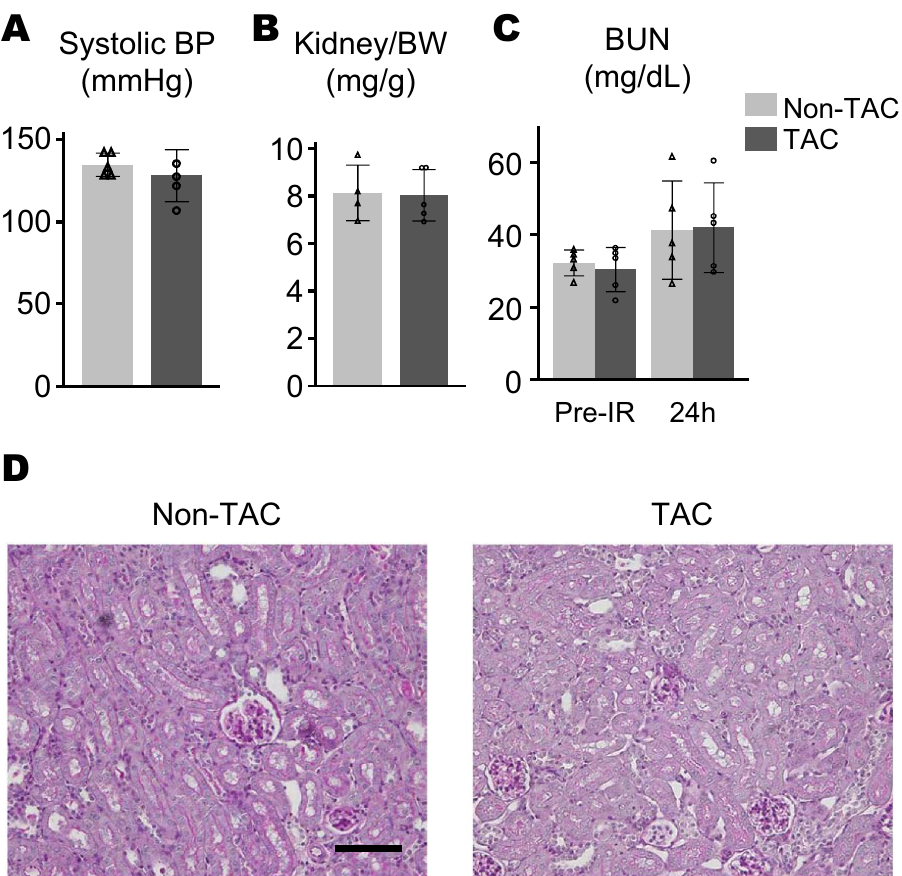
Figure 3. TAC had no effect on the acute phase after renal IR (Experiment 1). ( A ) Systolic blood pressure before renal IR, ( B ) kidney weight per body weight (BW) 24 h after renal IR, and ( C ) BUN before and 24 h after renal IR were similar between the non-TAC (n = 5) and the TAC groups (n = 5). Gray bar, non-TAC mice; black bar, TAC mice. ( D ) Representative image of renal pathology at 24 h after renal IR in PAS staining. (Bar = 100 μm). All graphs were created using JMP 14.0 software (SAS Institute Inc., Cary,